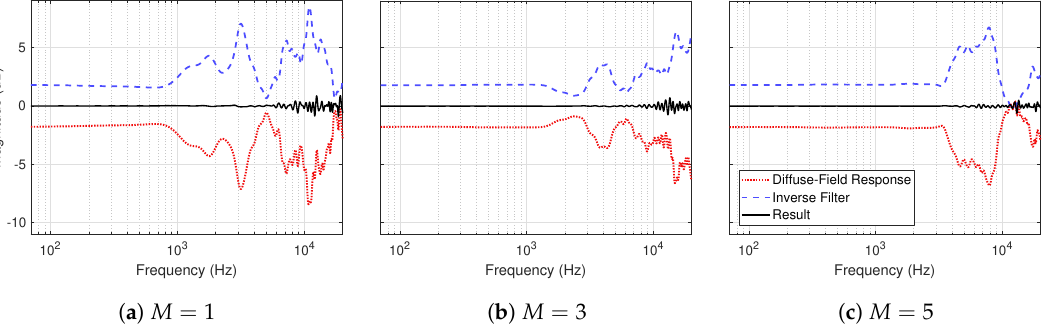
Figure 4. Diffuse-field response, inverse filters and resulting responses of the three tested Ambisonic configurations (left ear): ( a ) M = 1, ( b ) M = 3 and ( c ) M = 5.